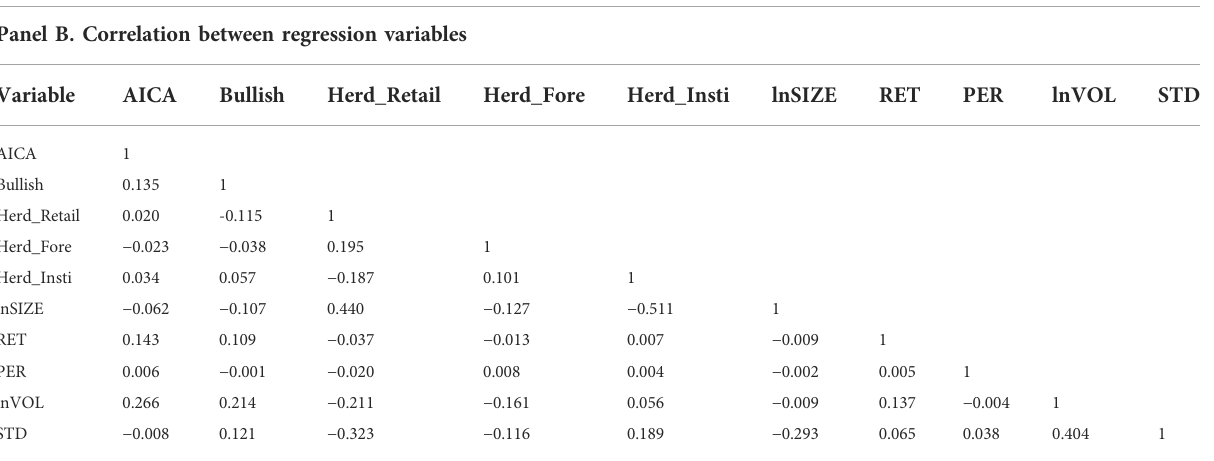
Panel B. Correlation between regression